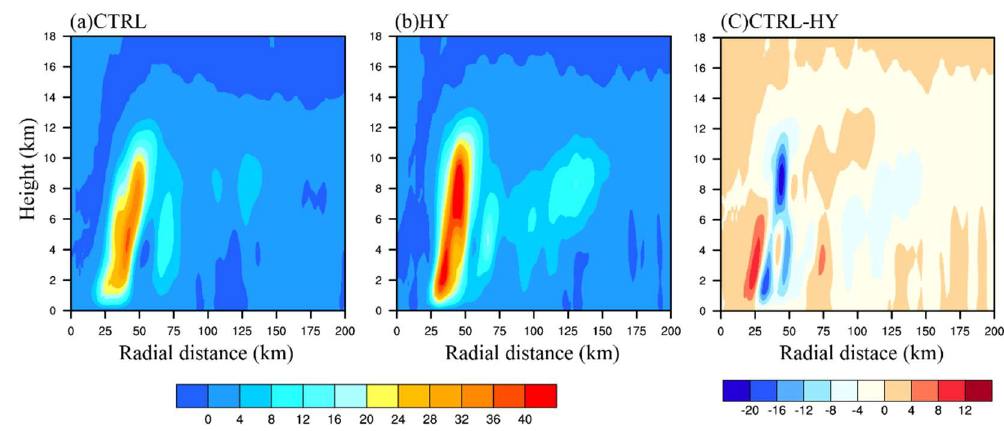
Figure 16. Height–radius cross-sections of the azimuthal mean latent heat release (K h −1 ) averaged between 84 and 96 h for ( a ) CTRL, ( b ) HY, and ( c ) CTRL-HY.